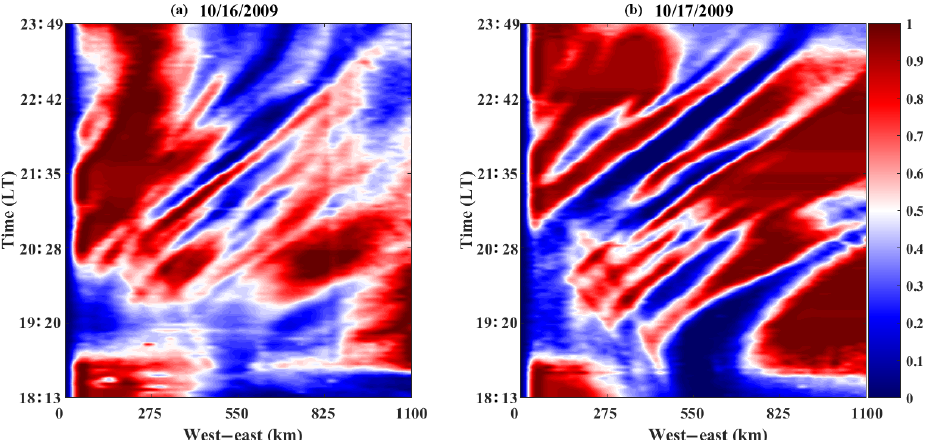
Figure 7. Keograms for 16 October 2009 (a) and 17 October 2009 (b)